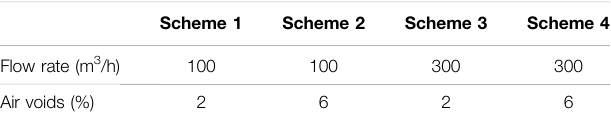
TABLE 1 | Selection of schemes.